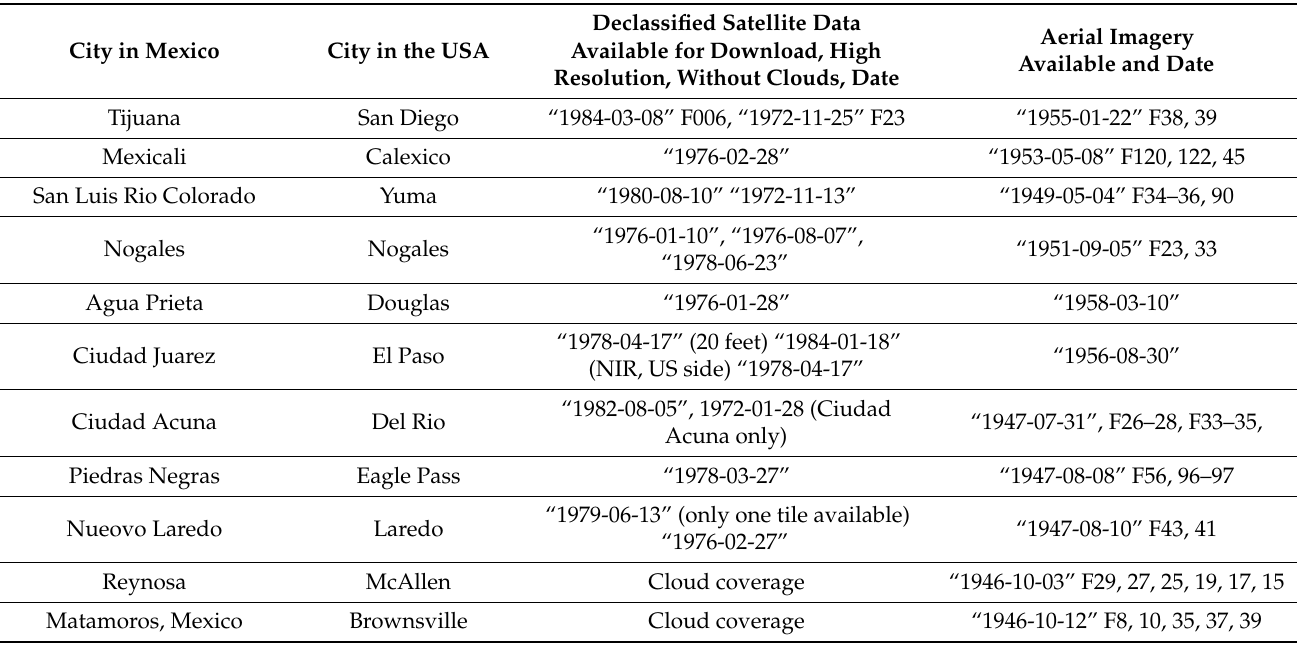
Table 2. Aerial and satellite imagery used for this